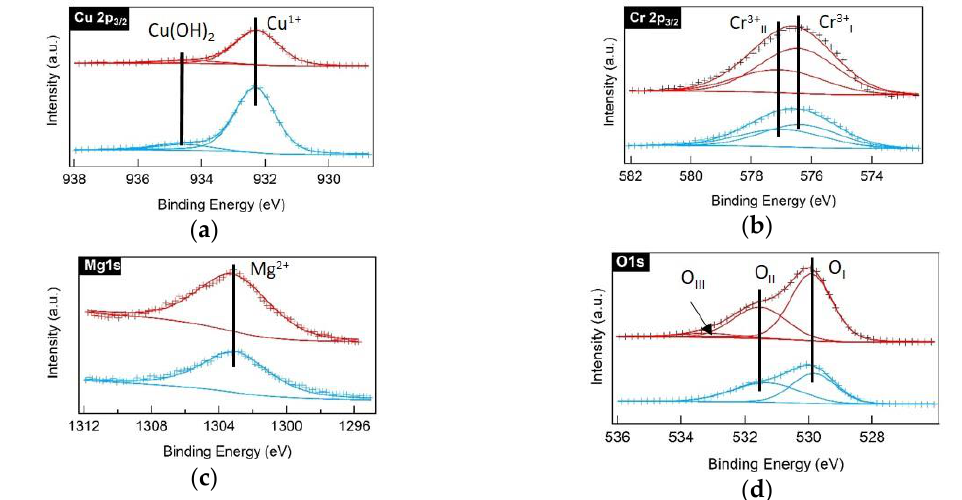
Figure 6. X-ray photoelectron spectroscopy (XPS) spectra of ( a ) Cu 2p 3 / 2 , ( b ) Cr 2p 3 / 2 , ( c ) Mg 1s, and ( d ) O 1s orbitals for 5% Mg:CCO (red) and 10% Mg:CCO (blue) nanoparticles. The measured XPS spectra are represented by cross symbols. The fitted XPS spectra are represented by solid curves. The black lines show the binding energies for Cu(OH) 2 , Cu 1 + , Cr 3 + I , Cr 3 + II , Mg 2 + , O I , O II , and O III . Cr 3 + I represents Cr 3 + as oxide, Cr 3 + II is Cr 3 + as hydroxide; O I represents the lattice oxygen, O II is hydroxyl species, and O III is adsorbed water.